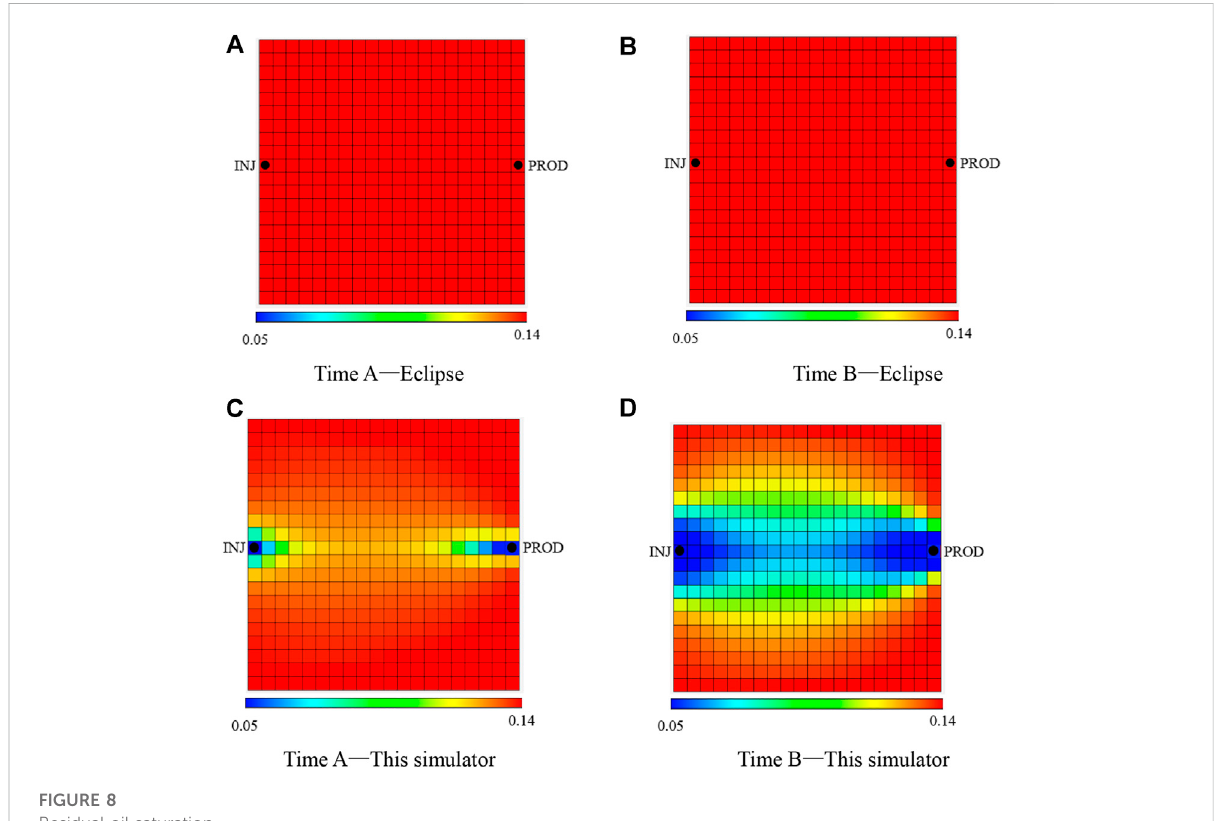
FIGURE 8 Residual oil